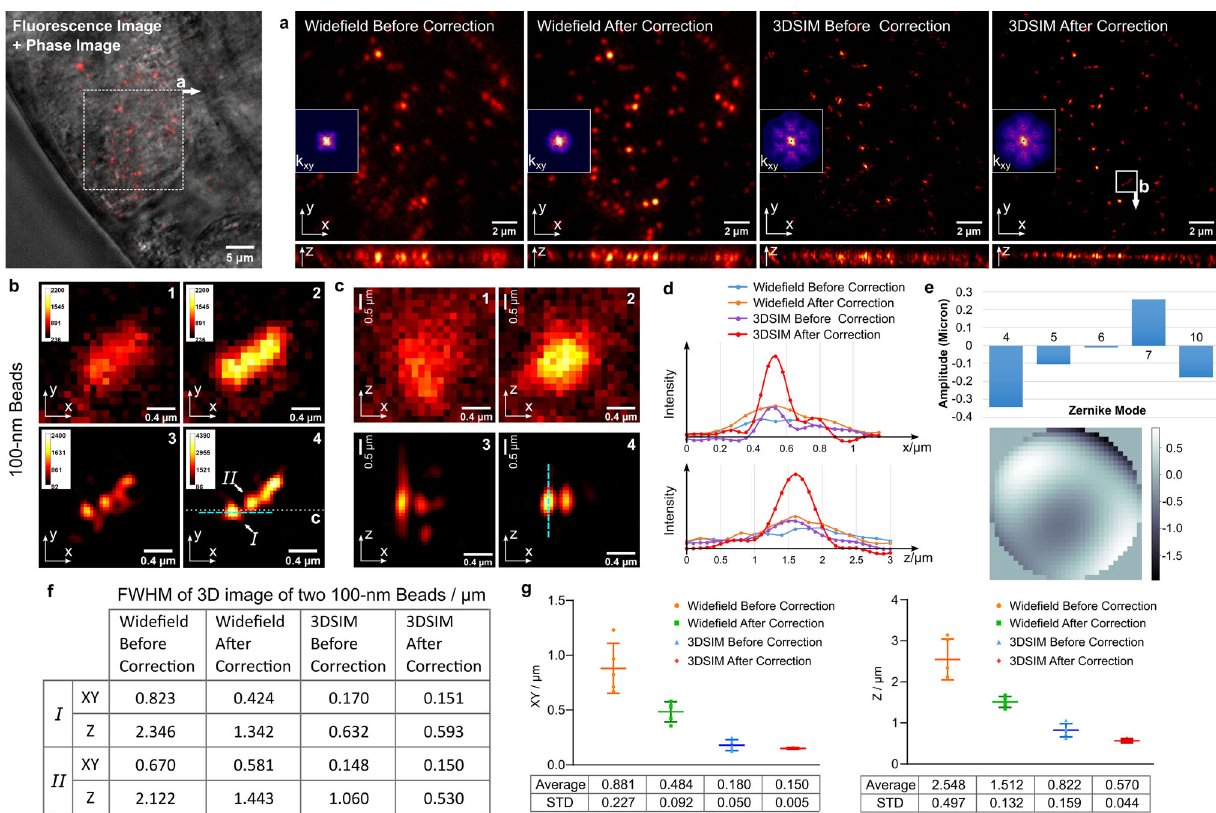
Fig. 4 Mixture of 100-nm and 200-nm fl uorescent beads under C. elegans . a In-focus x-y section images of area within white dotted-line square and the maximum intensity projection of their x-z sections, insets are the image spectrum. b Zoomed-in views of the area within the white square. c The x-z slice cut through the white dashed line. d Intensity pro fi les plotted along the blue dashed lines along both the x and z axis in wide fi eld and 3D-SIM images ( 1 . Wide fi eld image without AO correction; 2 . Wide fi eld image with AO correction; 3 . 3D-SIM image without AO correction; 4 . 3D-SIM image with AO correction). e The amplitudes of Zernike modes and the corrective wavefront applied on the DM, units in microns. f The table of the FWHM of 3D images of two 100-nm beads. g The scatter diagram of the average values and standard deviations of the FWHM of 3D images of 100-nm beads. n = 5 independent beads were measured. Source data are provided as a Source Data fi